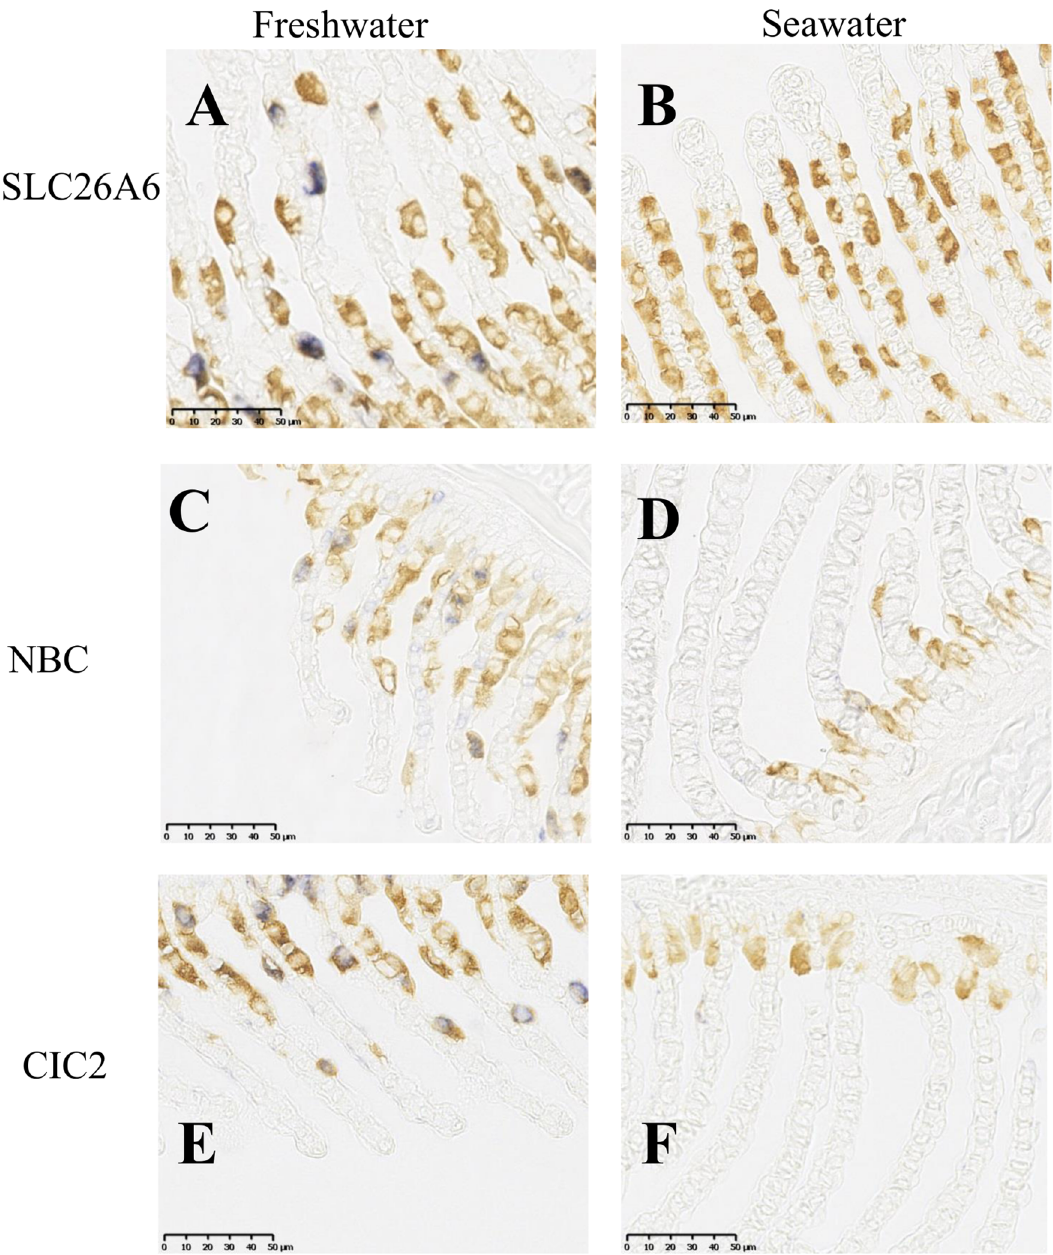
Fig 3. In situ hybridization of 3 genes (purple labelling) in fish gill from freshwater (A, C, E) or seawater (B, D, F) acclimated rainbow trout associated with immunocytochemistry of ionocyte with Na/K-ATPase antibody (brown labelling). AB: SLC26A6, CD: NBC, EF: